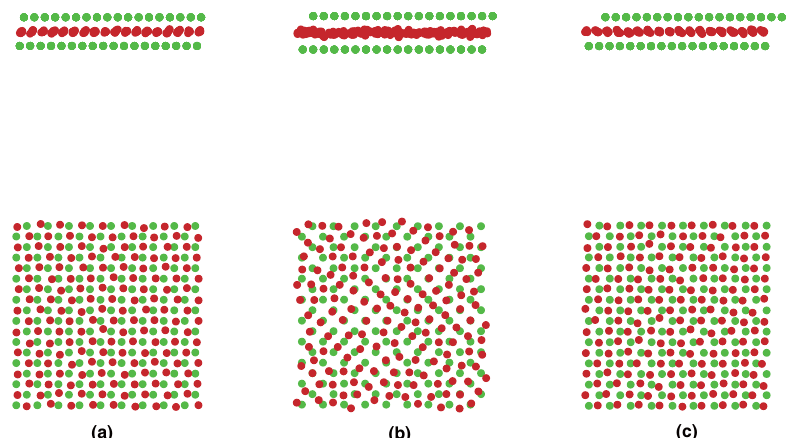
Fig. 6 Atomistic structures ( x – z side view and x – y bottom view) of the modeling tribological system at  (a) 0.2, (b) 0.5, and (c) 0.8. The wall, the rigid substrate, and the fluid atoms are represented by the green, green, and red spheres,